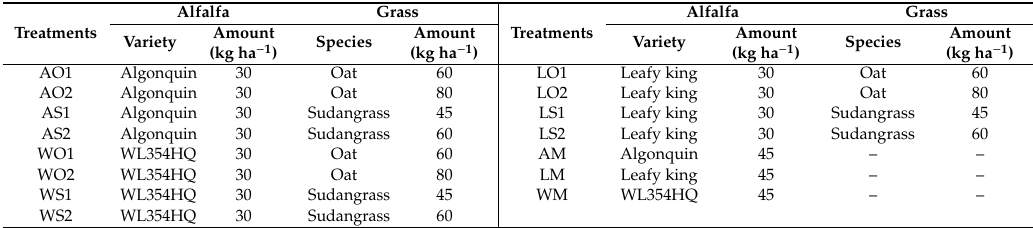
Table 1. Seeding amounts and abbreviations of all